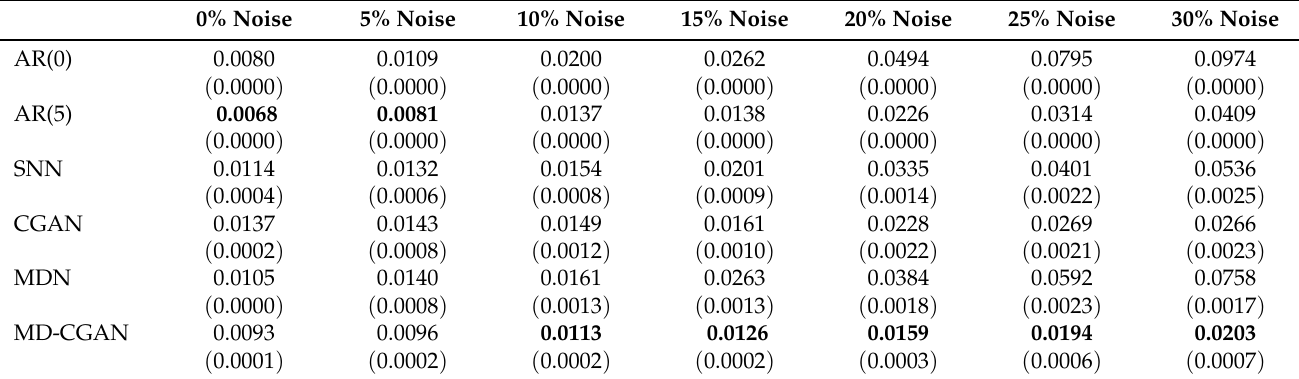
Table 2. Sunspot data: MSE variation with added noise level, with standard deviations in parentheses.